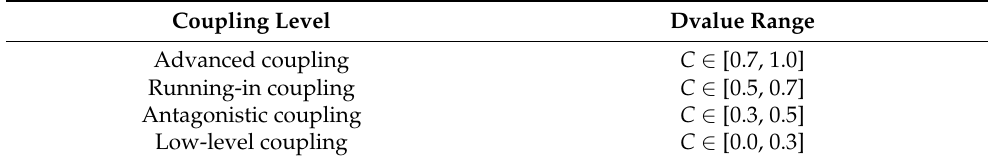
Table 2. Classification of coupling